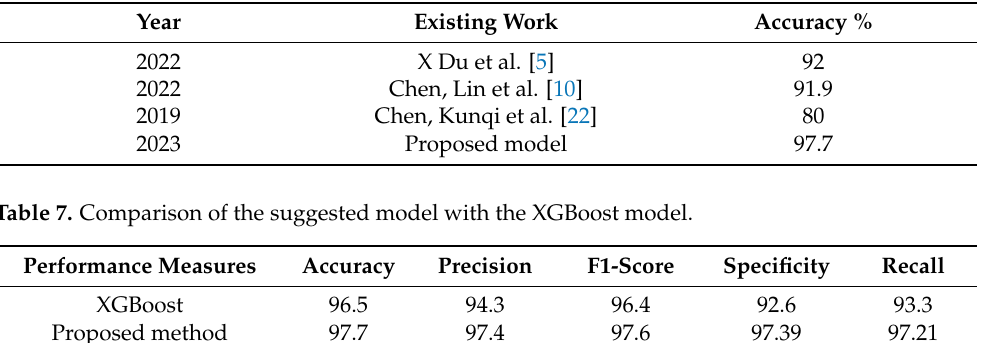
Table 6. Comparison analysis of the proposed model.